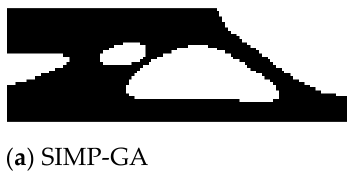
Figure 13. Optimization result when r = 8.